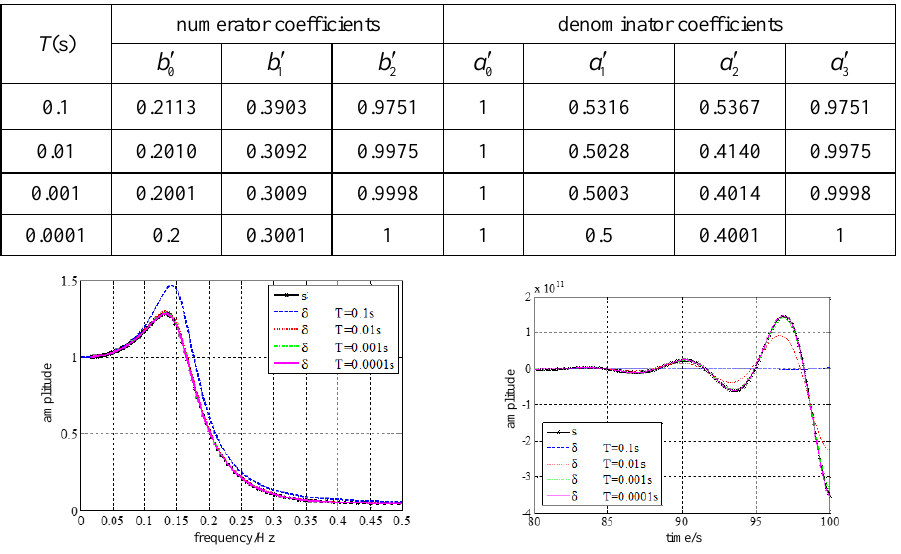
Table 1. Numerator and denominator coefficients of δ -domain model.